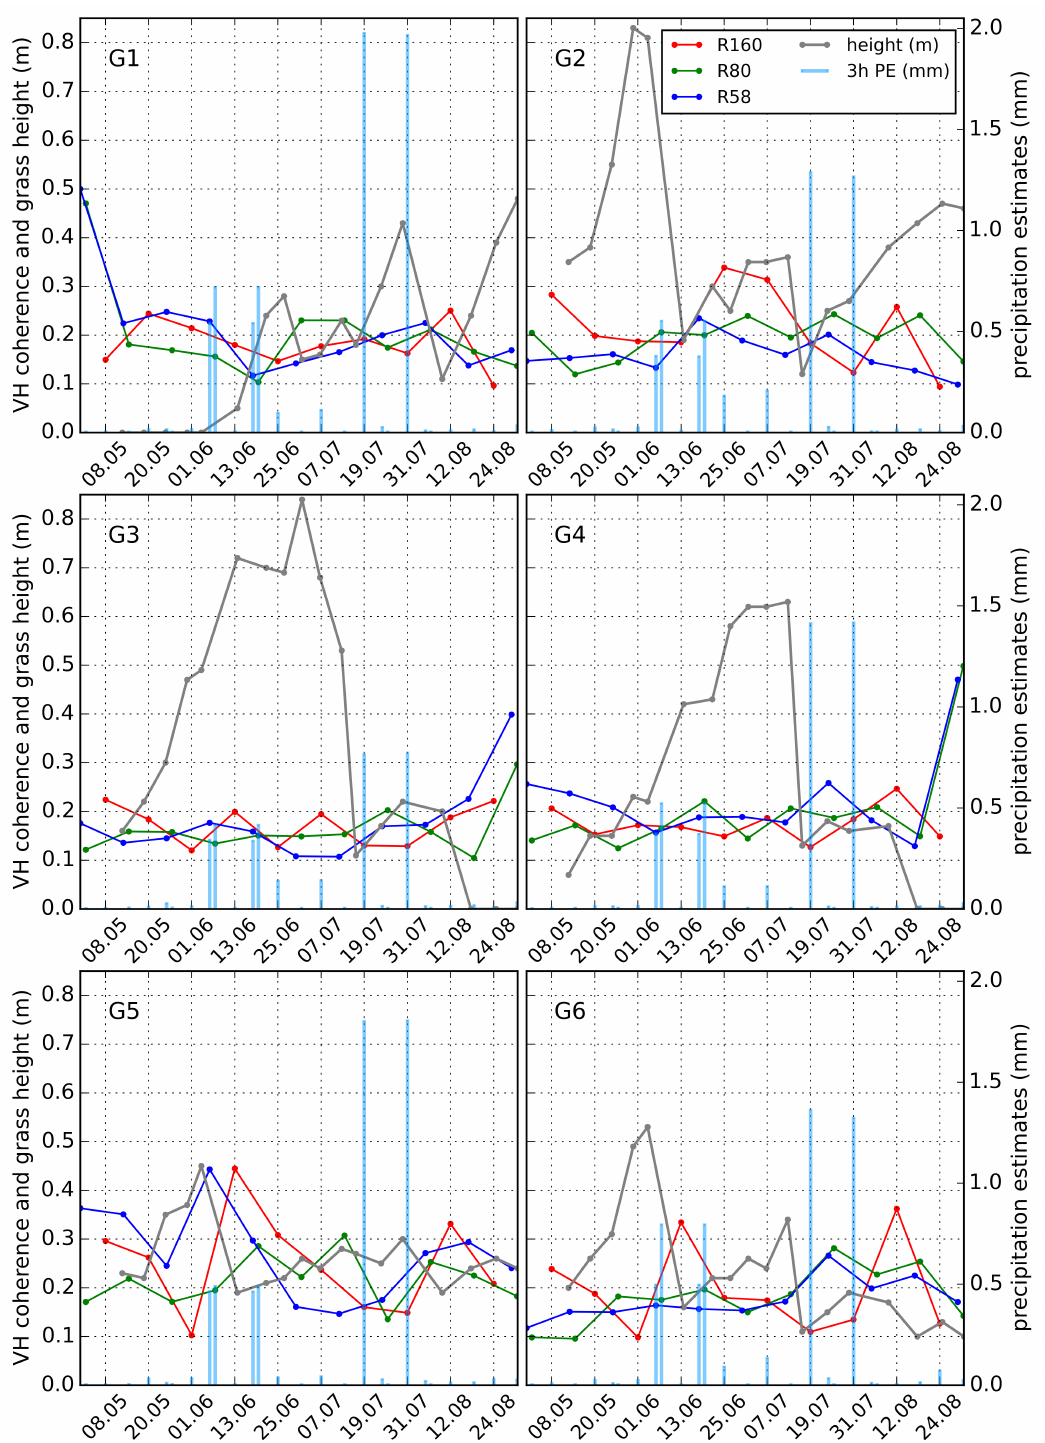
Figure 2. The 2015 time series of recorded height and coherence values for grasslands where the field survey was conducted. Polarization is vertical transmit, horizontal receive (VH). Date of the first image of the coherence pair is given on the x -axis. Vertical blue lines indicate the sum of 3-h precipitation estimates (PE) in mm for the image